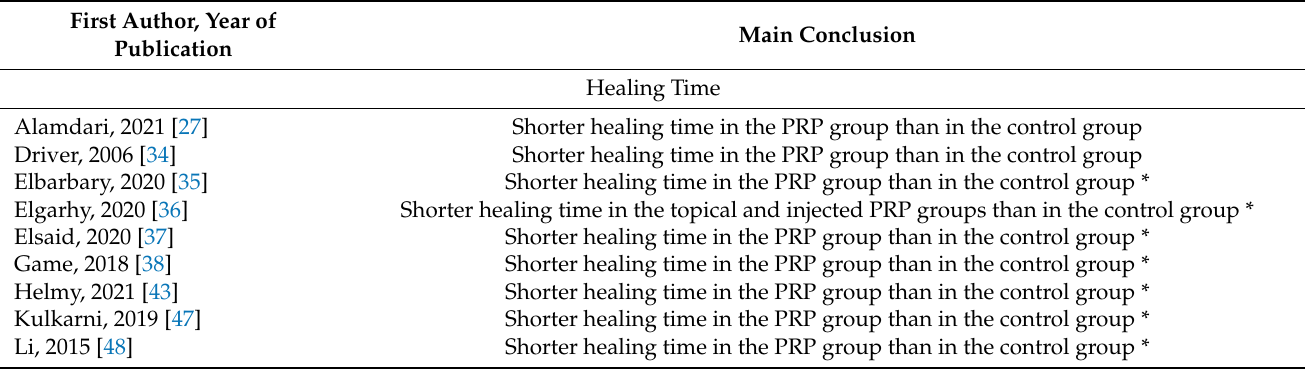
Table 2. Main conclusions of the studies assessing the secondary outcomes.